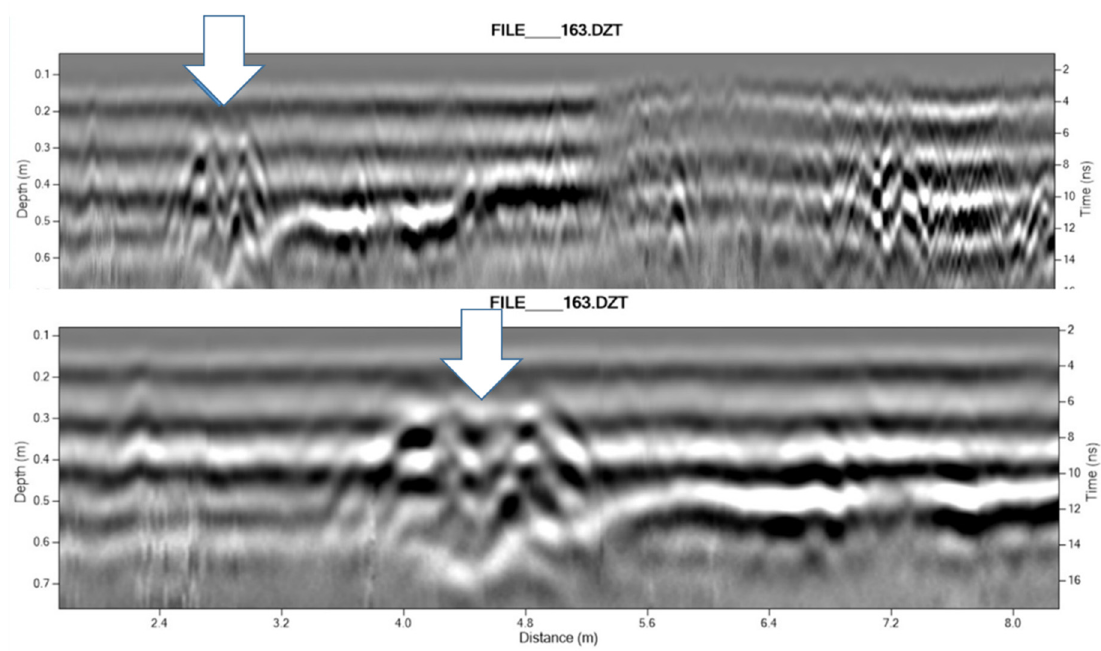
Figure 2. Two versions of a single feature profile at different scales. San Juan Bautista adobe wall crossing and strata.